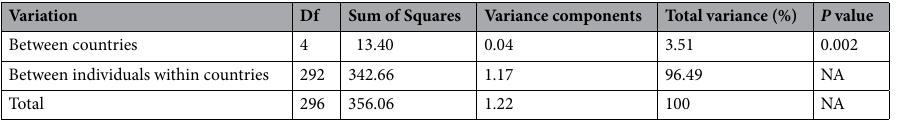
Table 1. Results of an amova to analyse differences between the six countries based on TpiI4. P value was calculated using a randomization test with 999 permutations.